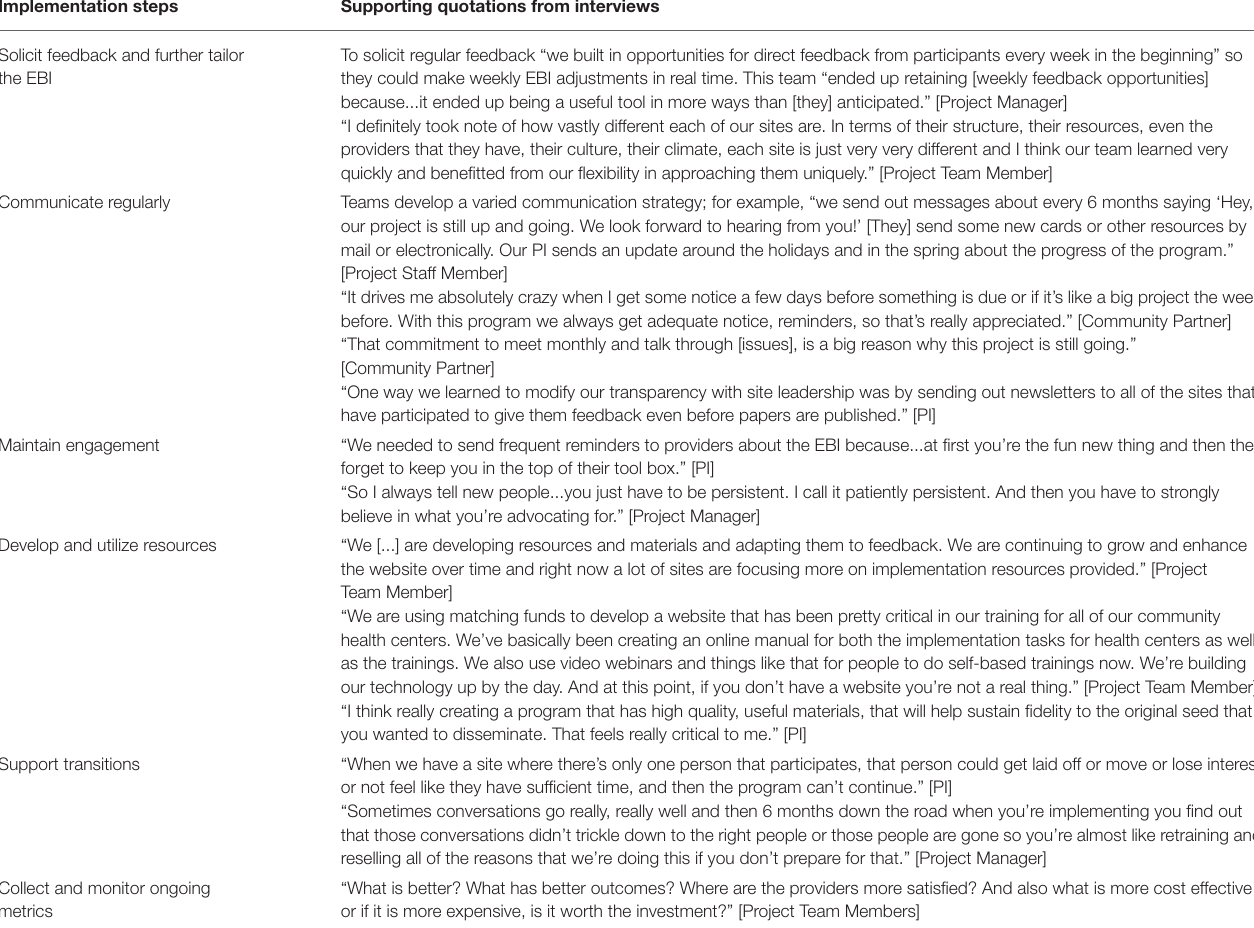
TABLE 5 | Implementation illustrative